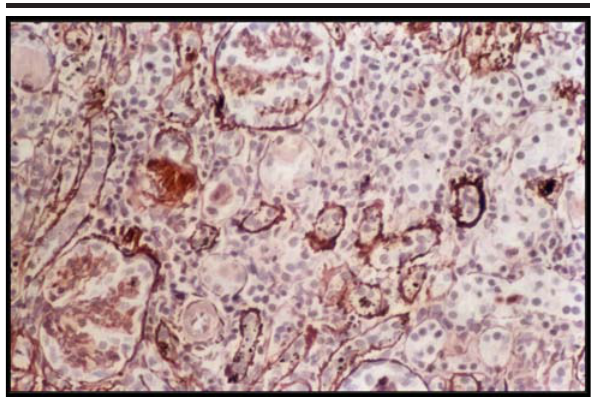
FIGURE 2 - Moderate tubular atrophy and interstitial infiltrate. Collapsed glomerules. Kidney from GI at the time 4 (28 days). PASM, 200 X.